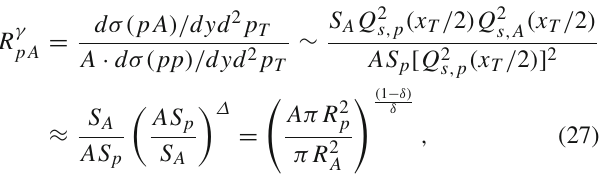
Fig. 5 Differential cross sections for prompt photon production in √ pPb collision at s = 8 . 16 TeV and considering three rapidity bins. The predictions are obtained using three phenomenological CD models